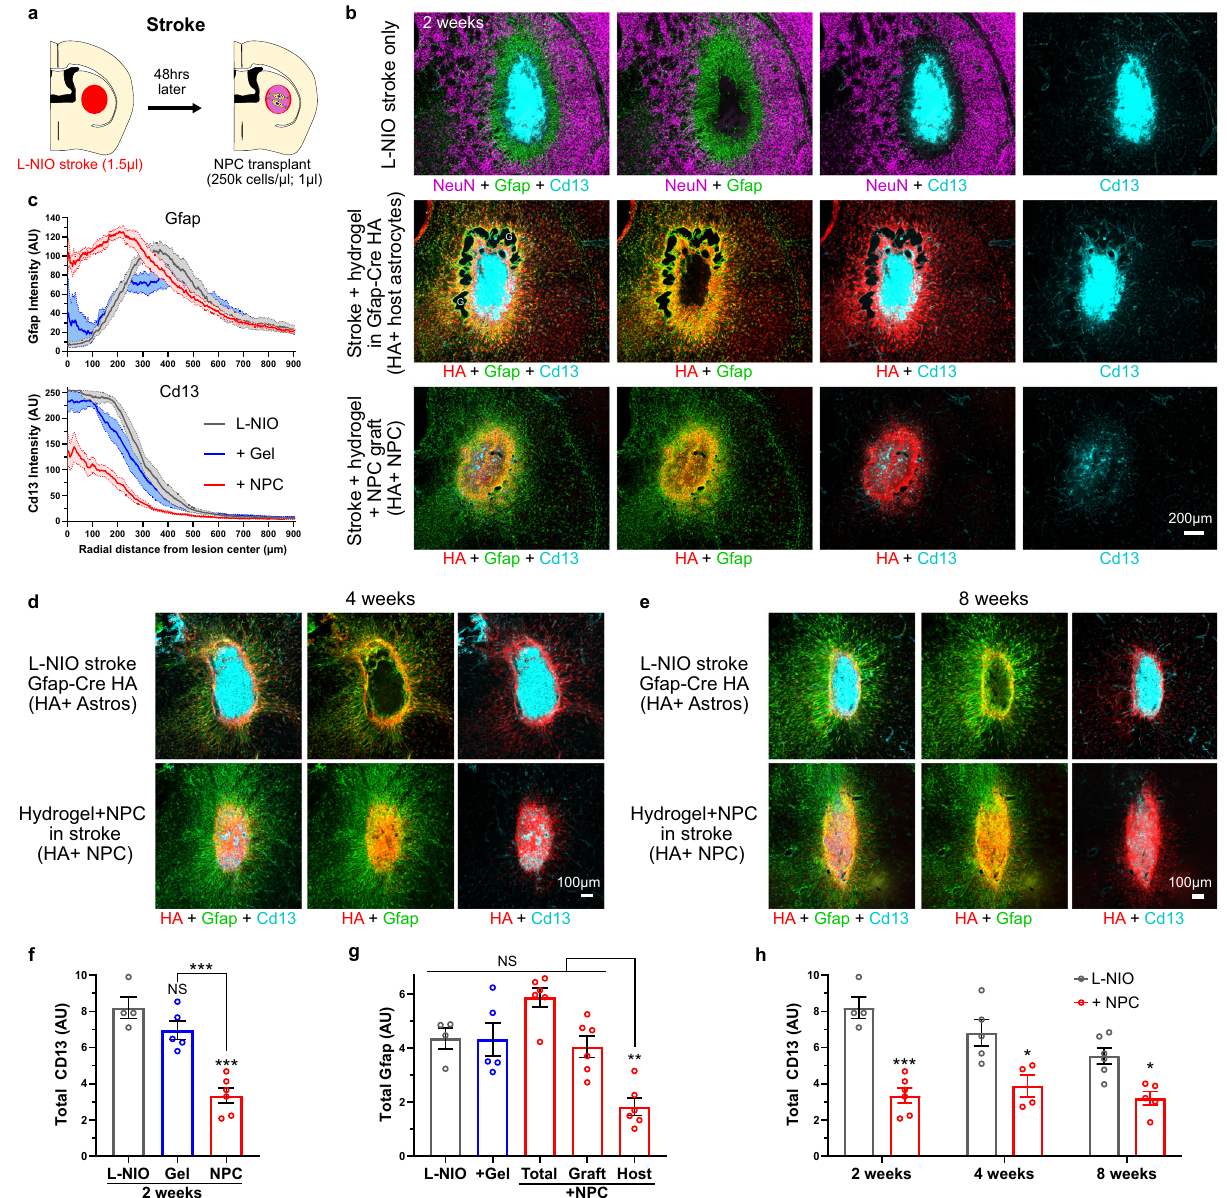
Fig. 4 | NPC grafted into striatal stroke generate astroglia that reduce fi brotic scar and bridge lesions. a Schematic summarizing experimental approach for evaluating NPC grafting in mouse striatal stroke. b Survey IIHC images of stroke lesions at 2 weeks comparing effect of hydrogel (DCH MO ) alone or grafted HA- positive NPC on stroke lesion phenotype.NPC grafted lesions show Gfap-positive lesions with reduced Cd13-positive tissue in non-neural lesion core. c Quanti fi cation of Gfap and Cd13 intensity at stroke lesions as a function of the radialdistancedfromthecenterofthelesionwithmean±s.e.m.(s.e.mrepresented as shaded region). d , e Survey IHC images of stroke lesions at 4 weeks ( d ) and 8 weeks ( e ) comparing the effect of grafted HA-positive NPC on stroke lesion phenotype. f Quanti fi cation of total Cd13 at stroke lesion cores at 2 weeks after L-NIO injection for stroke only, hydrogel (DCH MO ) alone, and NPC grafting by performing area under the curve (AUC) calculations of Cd13 traces in c. ( N =4 for